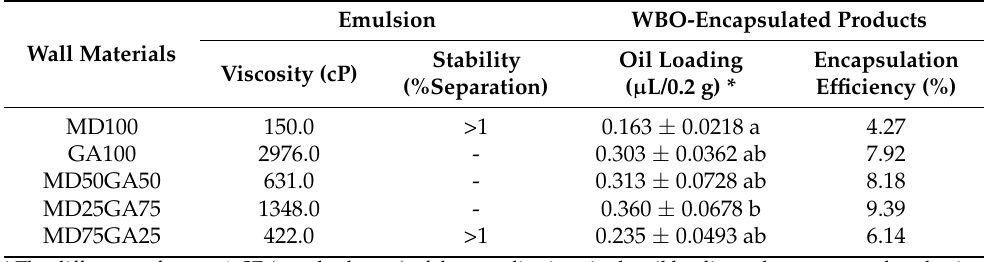
Table 5. Characteristics of the wall materials.